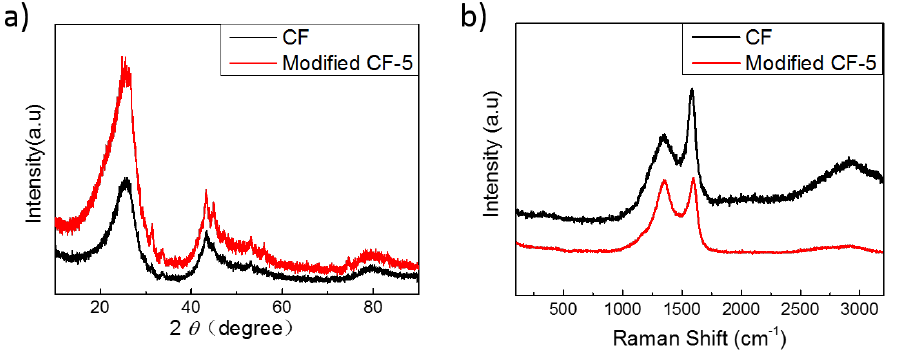
Table 2. XRD d-spacing values, graphitization degree and Raman I D / I G ratios of pristine CF and mCF- 5, respectively.